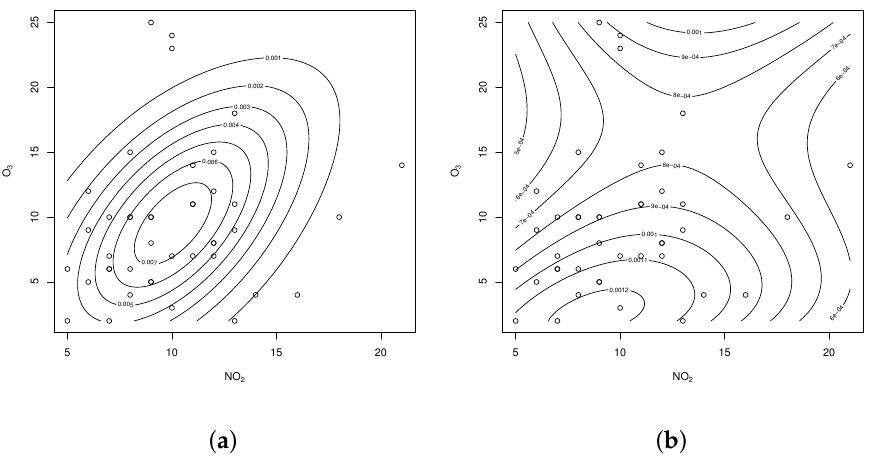
Figure 4. Contour plots. ( a ) BSHN model and ( b ) BSHPN